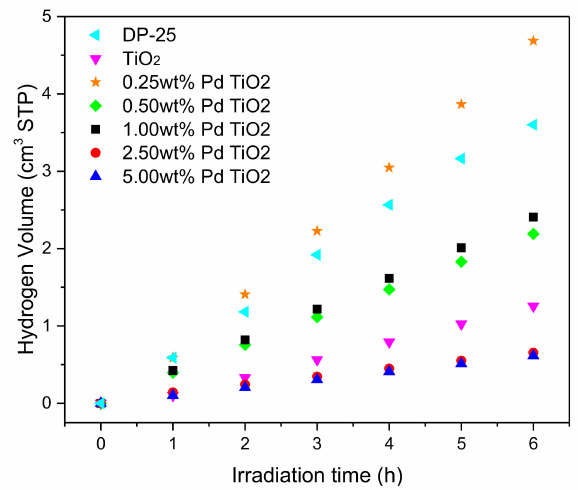
Figure 7. Cumulative Hydrogen Volume Using Pd-TiO 2 photocatalysts with Di ff erent Metal Loadings (0.25, 1.50, 1.00, 2.50 and 5.00 wt%). Conditions: photocatalyst concentration 0.15 g / L, 2.0 v / v % ethanol, pH = 4 ± 0.05 and visible light. Note: The experimental data reported is the result of 4 consecutive runs, each lasting 6 h. Standard deviation for repeats were +/ −